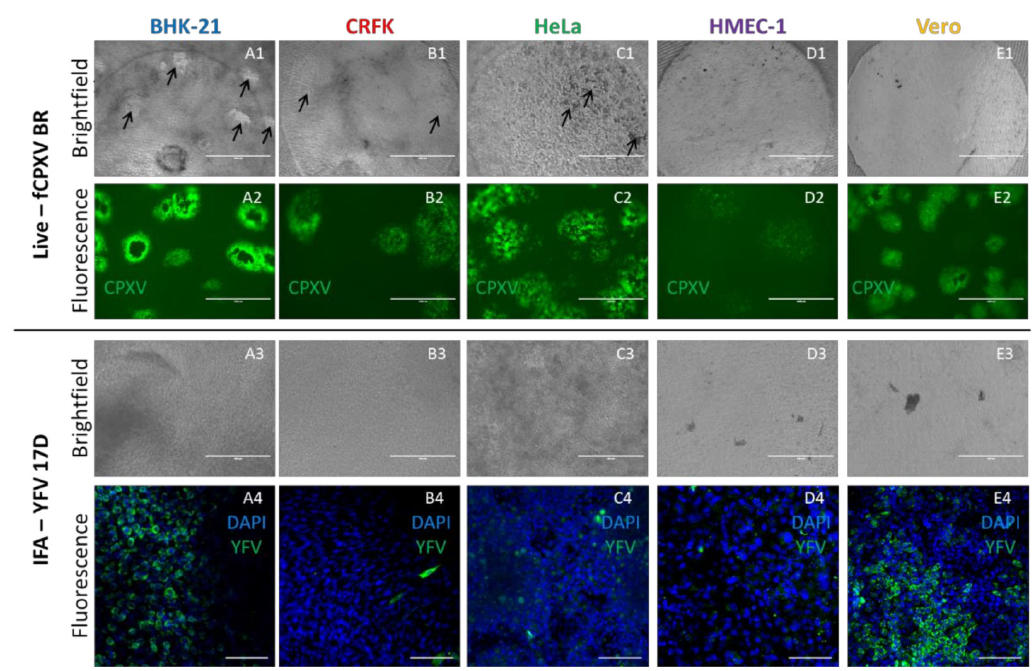
Figure 6. Direct in situ microscopy and horizontal immunofluorescence analyses of infected